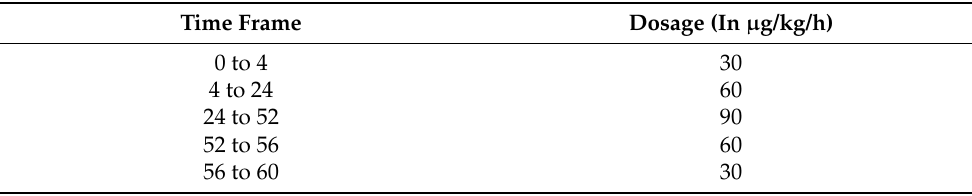
Table 1: Dosage of brexanolone during the 60-h infusion as described by Kanes et al.